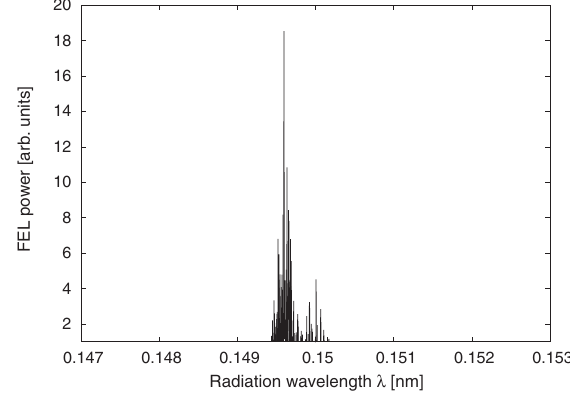
FIG. 10. FEL power spectrum at undulator 40